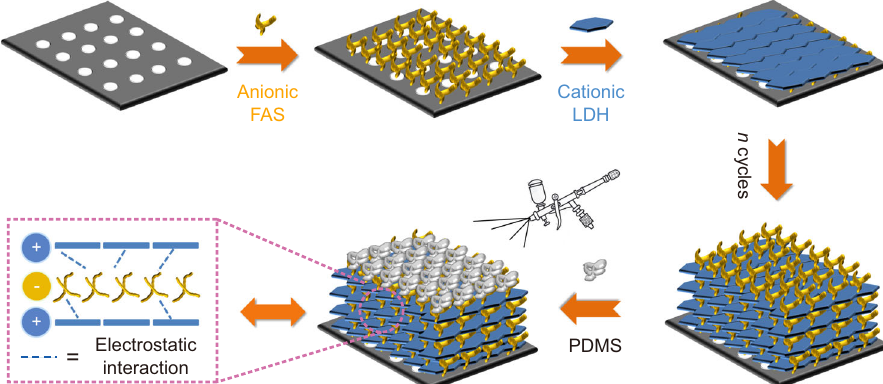
Fig. 1 Assembly of membranes. Schematic representation for the fabrication of (LDH/FAS) n -PDMS membranes.